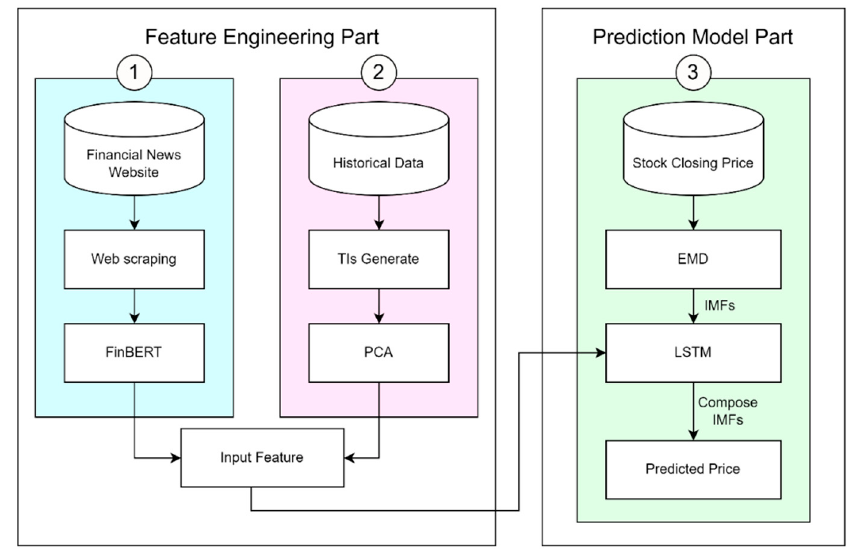
Figure 3. An overall view of the proposed hybrid framework.